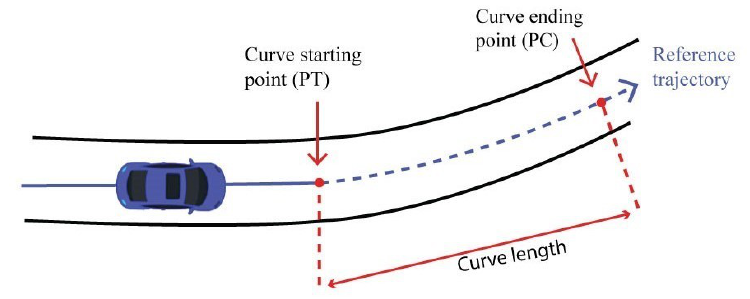
Figure 5. Curve driving